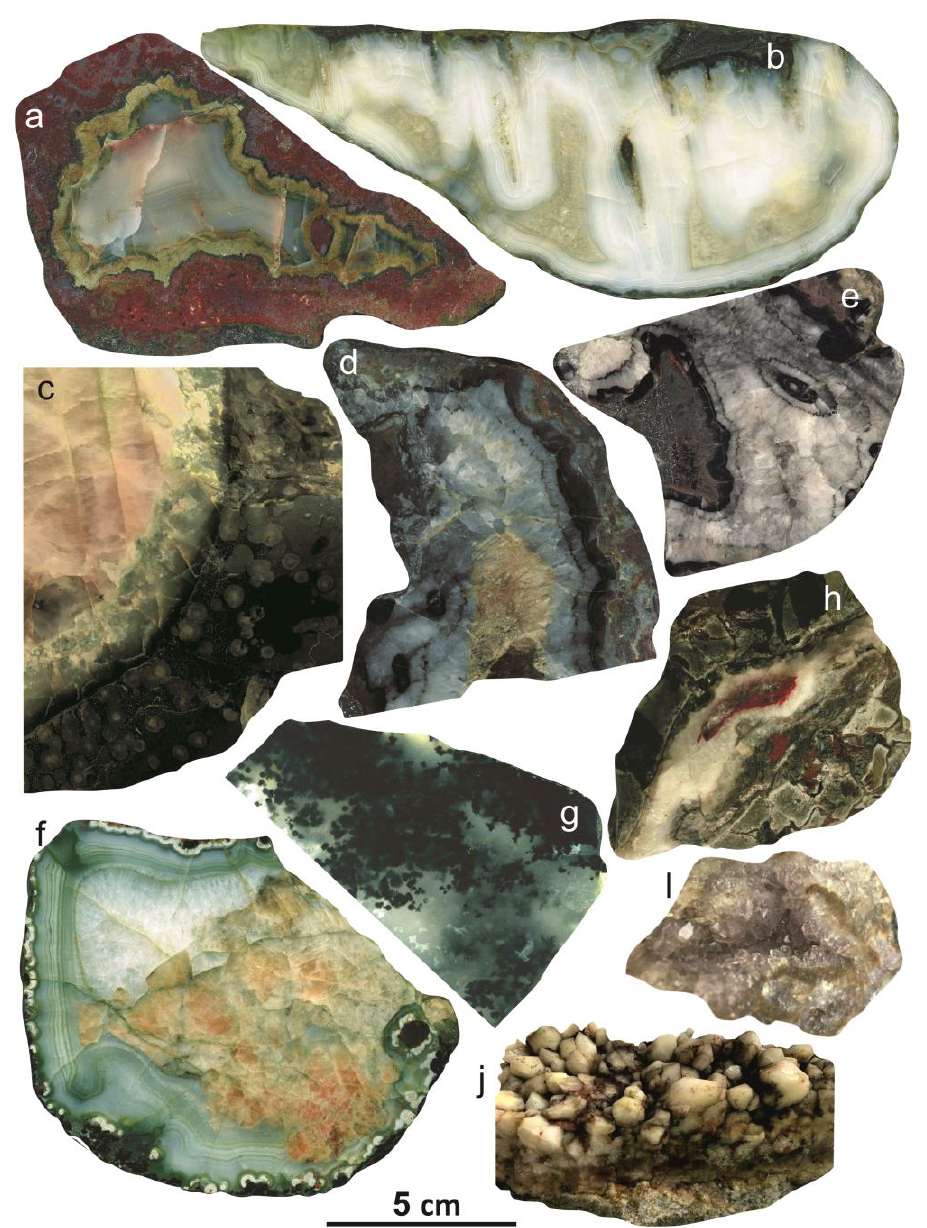
Figure 4. Macrophotographs of Onega agates: ( a ) concentrically zoned agate with green-colored chlorite pigment in the outer layer (Pinguba); ( b ) pseudostalactites of chalcedony in agate amygdule (Suisari Island); ( c ) chalcedony / calcite agate amygdale in variolitic pycrobasalt lava (Yalguba Ridge); ( d , e ) quartz / chalcedony agates with black-and-white graphic ornament (Suisari Island); ( f ) concentric zonedagatewithrosycalciteandquartzcrystalsinthecore(Tulguba); ( g )mossagatewithcarbon-bearing inclusions (Suisari Island); ( h ) agate with finely dispersed hematite in core in a lava-breccia vesicle (Tulguba); ( i ) amethyst geode from basalt vesicle (Tulguba); ( j ) druse of milky quartz crystals covered Fe-hydroxide film from a fissure in basalt